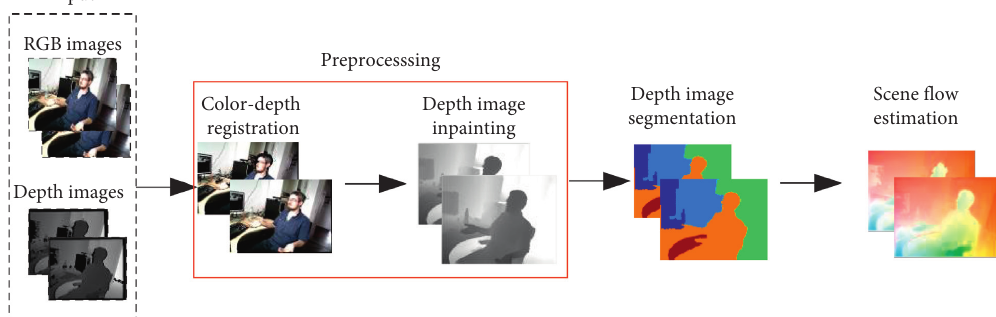
Figure 1: The framework for RGBD scene flow estimation. This framework shows the steps of RGBD scene flow